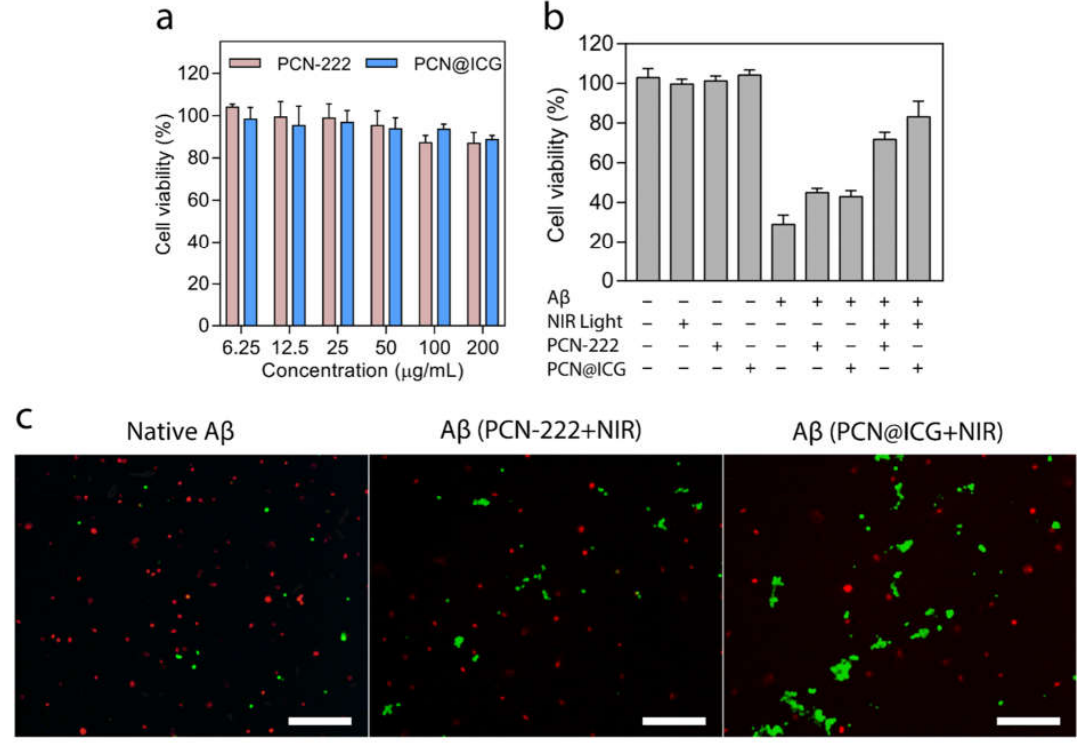
Figure 6. ( a ) Evaluation of cytotoxicity of PCN − 222 and PCN − 222@ICG to PC 12 cells. ( b ) PC 12 cell viability was rescued in the presence of A β 42 at a concentration of 25 µ M when treated with photo-activated PCN − 222 and PCN − 222@ICG. Each group contained three technical replicates. ( c ) Live/dead staining of PC 12 cells co-cultured with native A β 42 and A β 42 treated with photo- activated PCN − 222 and PCN − 222@ICG. Scale bar: 200 µ m (NIR laser irradiation is 808 nm with